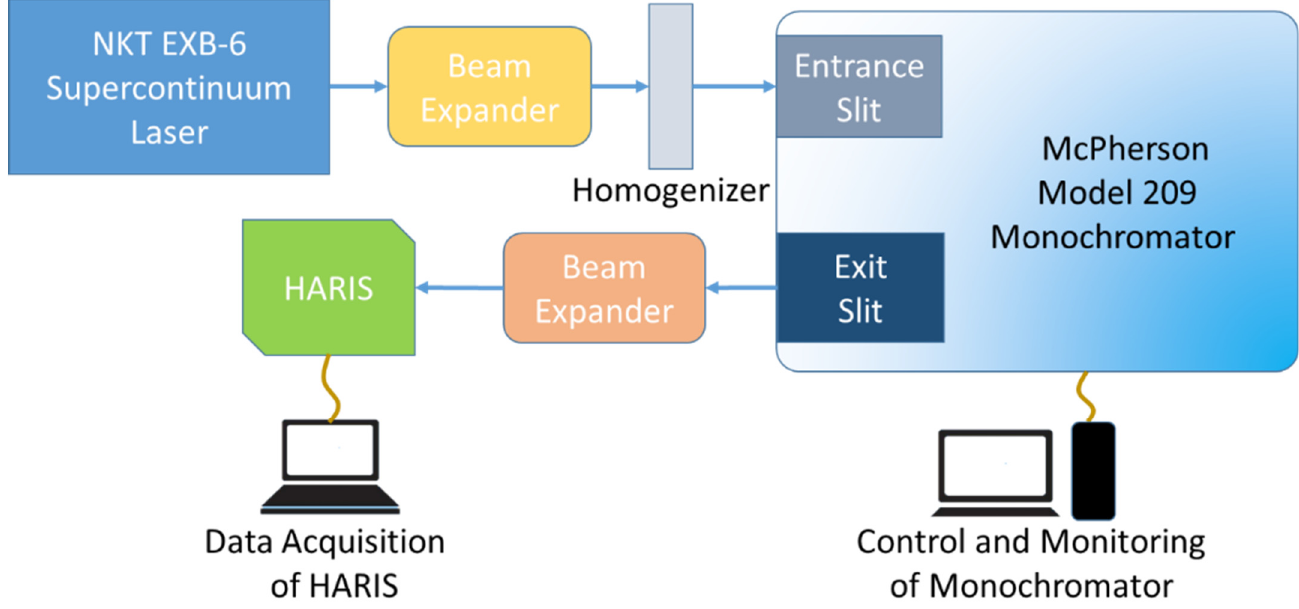
Figure 3. Diagram depicting the equipment for the wavelength calibration of HARIS. After calibrating the monochromator, the wavelength calibration of HARIS was per- formed using the above system. For this optical design, the wavelength scan interval for the pixel-by-pixel calibration was taken as one-third the amount of the designed spectral resolution at 0.15 nm, and a total of 148 points were scanned from 757 to 779.05 nm. Figure 4 shows the response of the 150th column on the HARIS image plane at 770.05 nm.